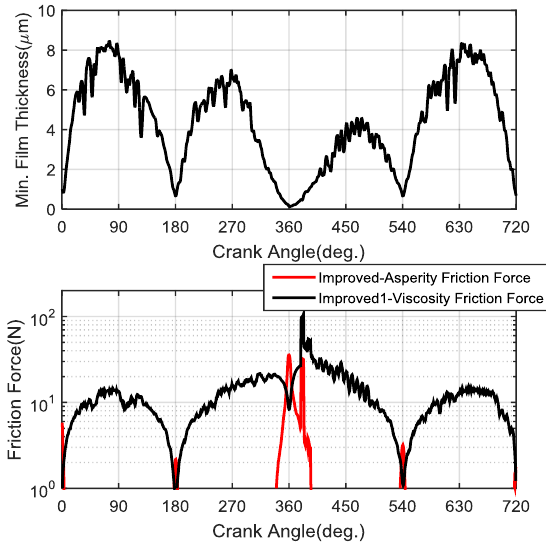
Figure 10. Minimum oil film thickness and friction force predicted based on improved model 1 considering dynamic deformation.